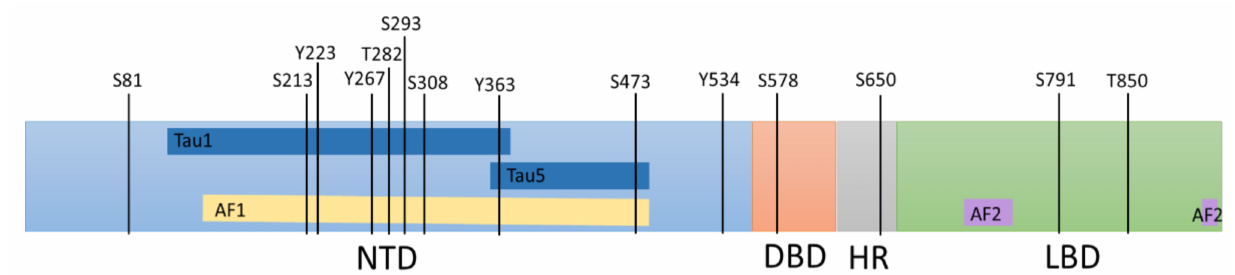
Figure 1. A schematic summarising the phosphorylated sites within the androgen receptor which moderate its activity. The androgen receptor contains several serine (S), threonine (T), and tyrosine (Y) residues that can be phosphorylated to moderate localisation, stability, and transactivation activity. Amino terminus transactivation domain (NTD), the DNA binding domain (DBD), the Hinge region (HR), and the ligand-binding domain (LBD). The activation function 1 (AF1) region (yellow line) consist of the majority of Tau1 and Tau5 (dark blue lines). The activation function 2 (AF2) region (purple lines) in the LBD is primarily located in the 12th helix; however, parts of the 3rd and 4th helixes also make up the AF2 surface